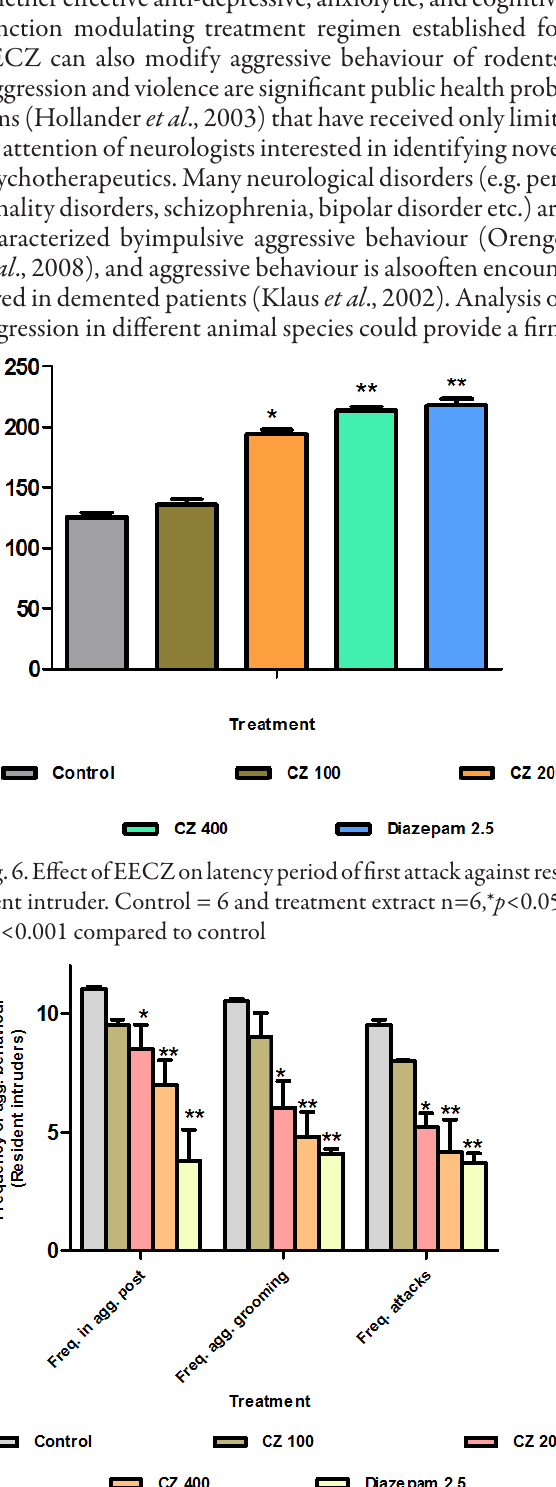
Fig. 7. Effect of EECZ on frequency of various resident in- truder aggressive behaviors. Control = 6 and treatment extract n=6,* p <0.01, ** p <0.001 compared to